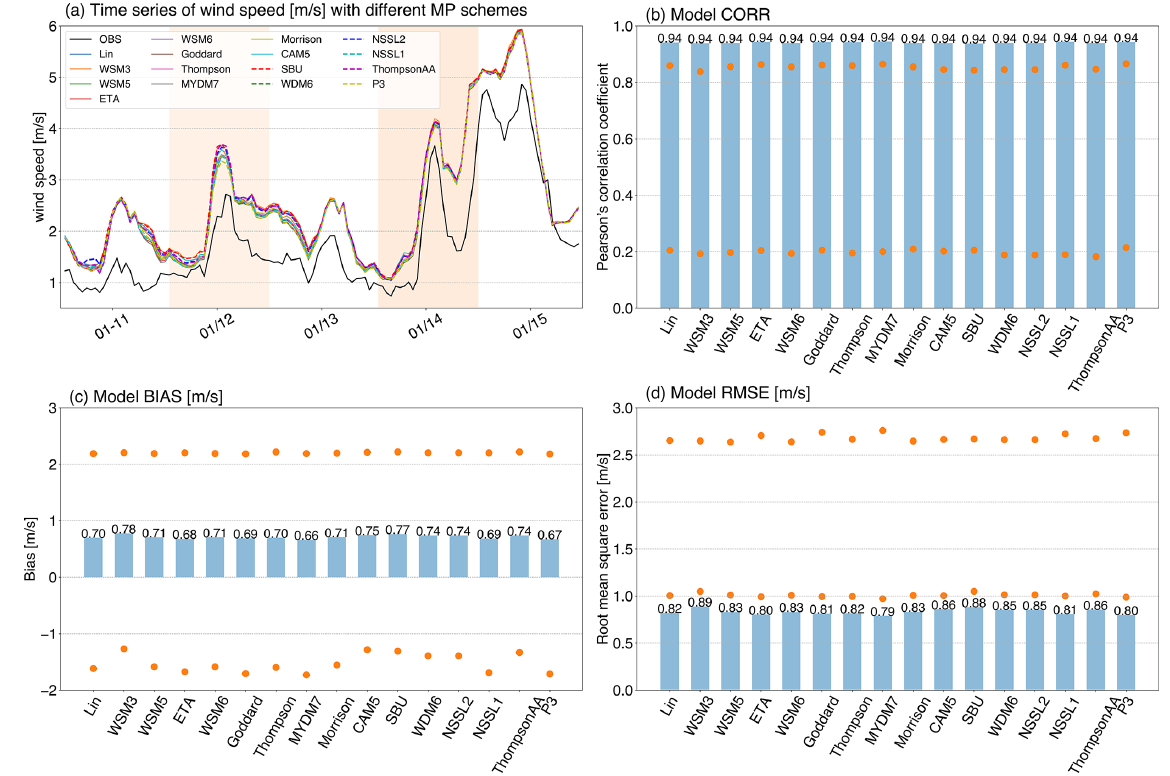
Figure 5. Same as Fig. 3 but for the MP